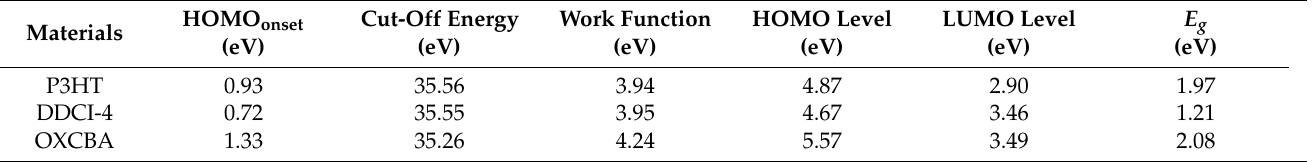
Figure 3. UPS spectra and representation of ( a ) HOMO onset ; ( b ) cut-off energy for determination of work function and HOMO level; ( c ) Tauc plot for determination of energy gap. Table 1. Calculated HOMO and LUMO levels of P3HT, DDCI-4, OXCBA.